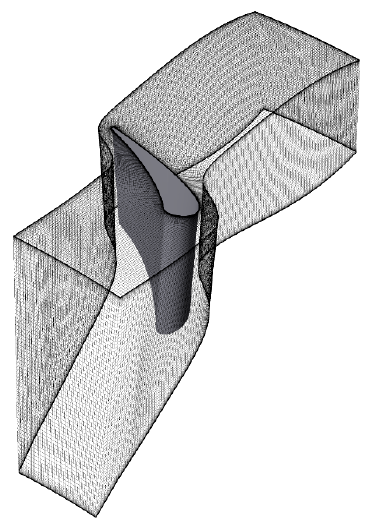
Figure 4. Comparison between experimental [23] and CFD values of vane efficiency at a plane located 10.16 mm downstream of the vane trailing edge. Chemical reactions were included in the CFD simulations with two different ap- proaches: one considering only finite-rate chemistry (FRC) without turbulence-chemistry interaction and the other using a turbulence-chemistry interaction model, namely the Eddy Dissipation Concept (EDC). This choice allows for a comparison with previous works and to assess the effect of turbulence on the reactions. The EDC model follows the assumption that chemical reactions occur within turbu- lent fine scales and that reaction rates are proportional to the mass transfer between these fine scales and their surroundings. The formulation employed in this work [27] defines